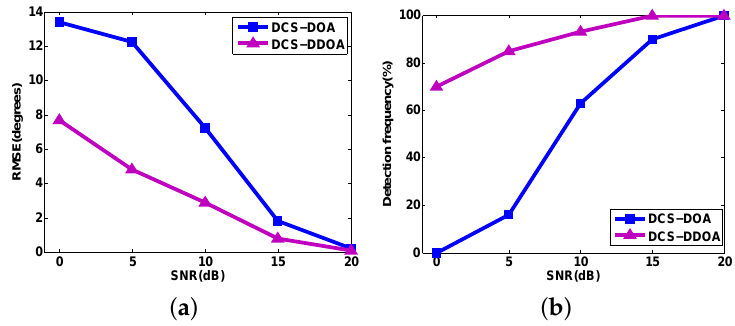
Figure 18. The comparison of DOA estimation RMSE and detection frequency between DCS-DOA and DCS-DDOA under a varying SNR with the packet size being 64 and M being